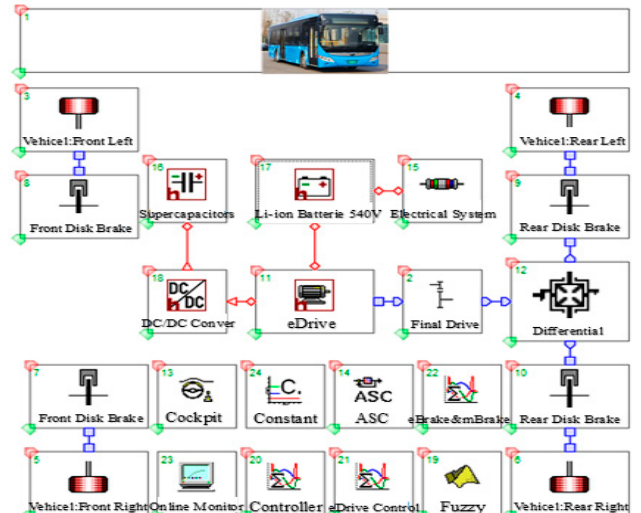
Figure 5. Vehicle model establishment relationship